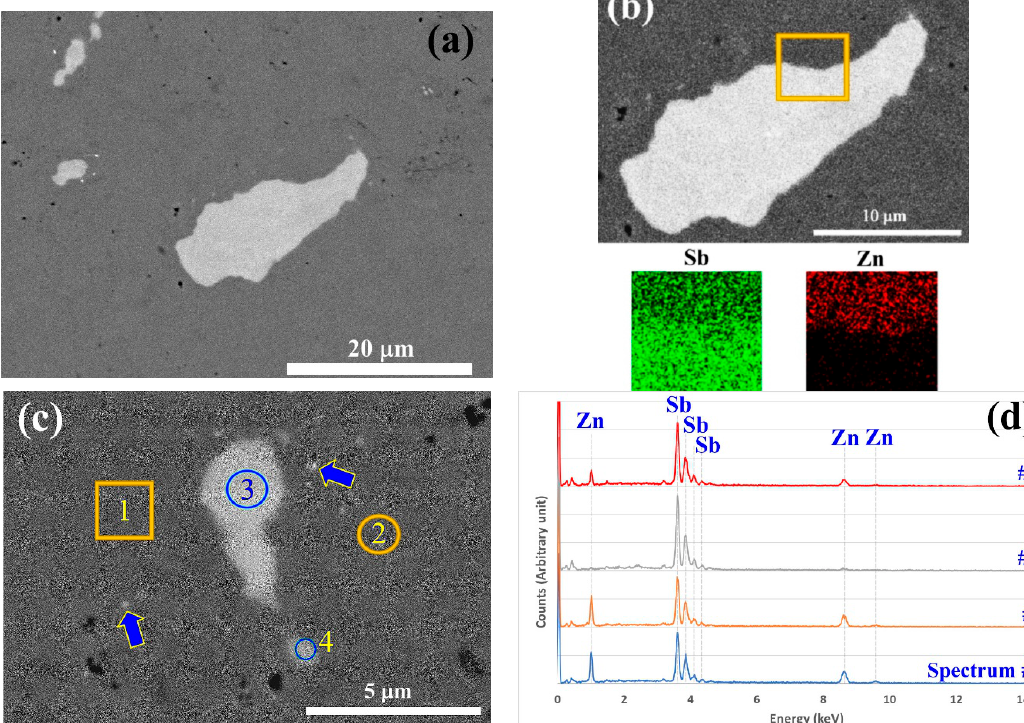
Figure 8. Backscattered electron images ( a – c ) of extruded ZnSb that show Sb-rich regions within the ZnSb matrix. ( b ) The energy dispersive X-ray spectroscopy (EDS) map of the selected area with a high content of Sb and very low amount of Zn. Arrows in panel ( c ) show sub-micron Sb-rich particles. ( d ) EDS spectra of the selected areas indicated in panel ( c ).